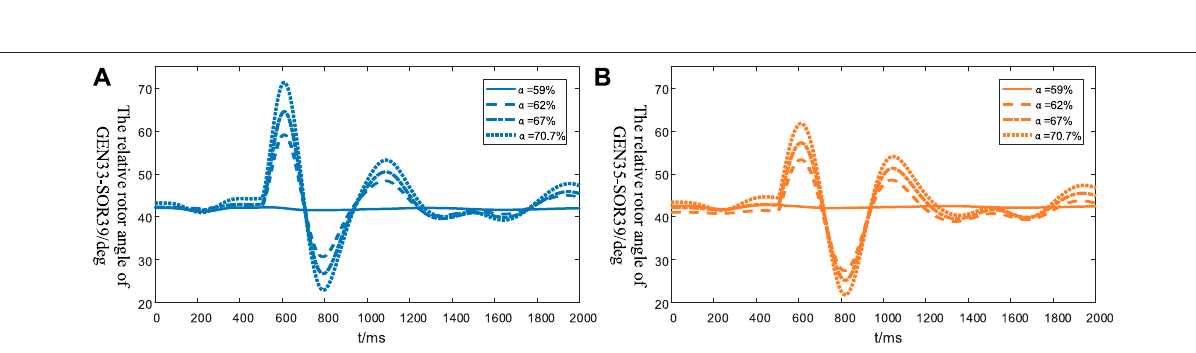
Frontiers in Energy Research |